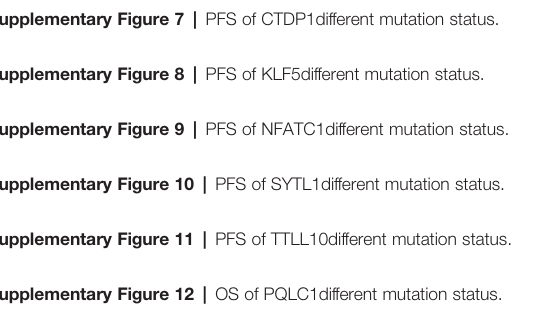
Supplementary Figure 1 | Comparison of clinical features between the two group. Supplementary Figure 2 | Comparison of four highly con fi dent mutational signatures (S1, S2, S3, and S4) derived in the SCH cohort with those in the COSMIC dataset using Cosine similarity analysis. Supplementary Figure 3 | PFS of OR4C6 different mutation status.PFS, progression-free survival. Supplementary Figure 4 | PFS of PTPN13different mutation status. Supplementary Figure 5 | OS of LRP2 different mutation status.OS, overall survival.